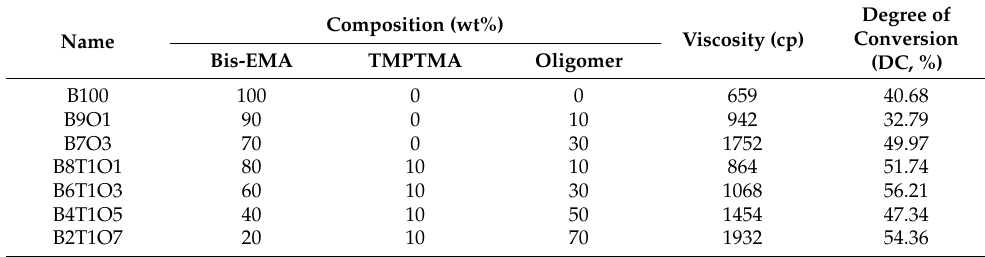
Figure 2. Viscosity of various 3D printing resins. Table 2. Composition and degree of conversion of urethane acrylate resin